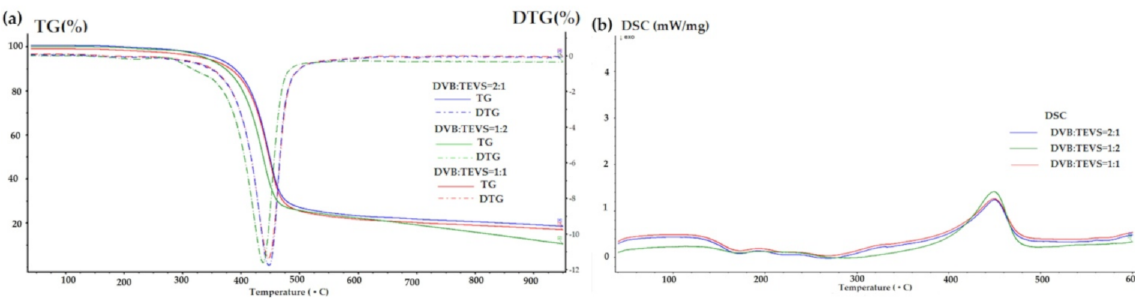
Figure 13. TG, DTG ( a ) and DSC ( b ) curves for DVB-TEVS materials measured in helium conditions after adsorption of 4-NP.